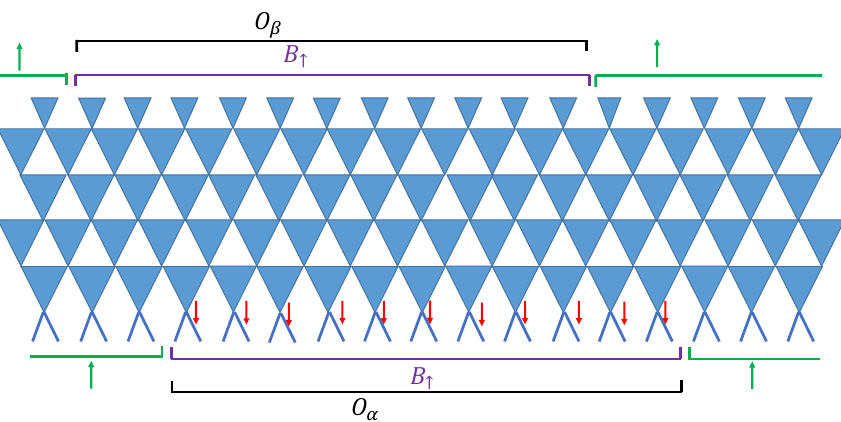
Figure 18 . We show the lattice for the partition function corresponding to (A.1) for a particular choice of O α and O β , both without voids, and t = 5 . The boundary conditions, and the spins in the bulk fixed by the boundary conditions through the rules in figure 19, are shown explicitly. The remaining spins can be either up or down.